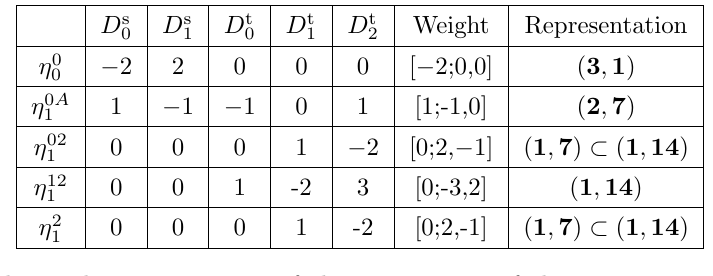
Figure 4 . Codimension-two Collision of SU(2) (cid:2) G type III (cid:3) (with dual graph e E 7 ) with contracted nodes.